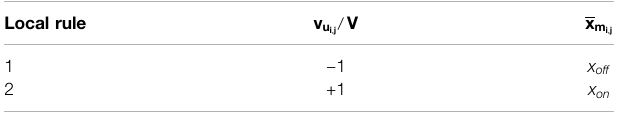
TABLE 5| Pair oflocalrules, which theM-CNN cell C ( i , j ) isrequested toobey, so astomapthewhite(black)pixelinthecorrespondingpositionofagiven M ×